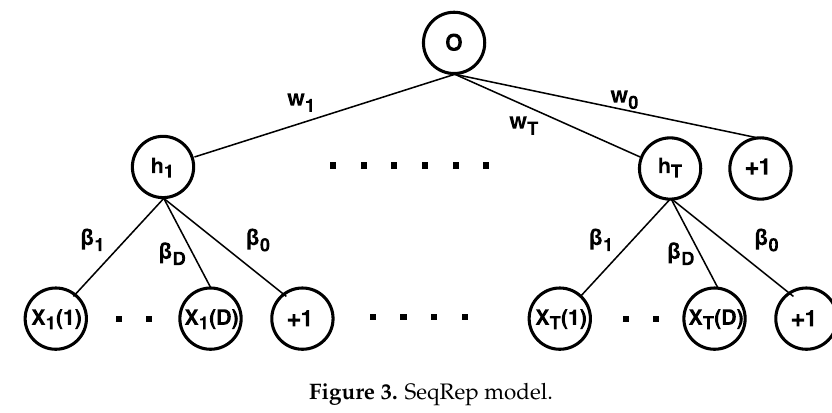
Figure 3. SeqRep